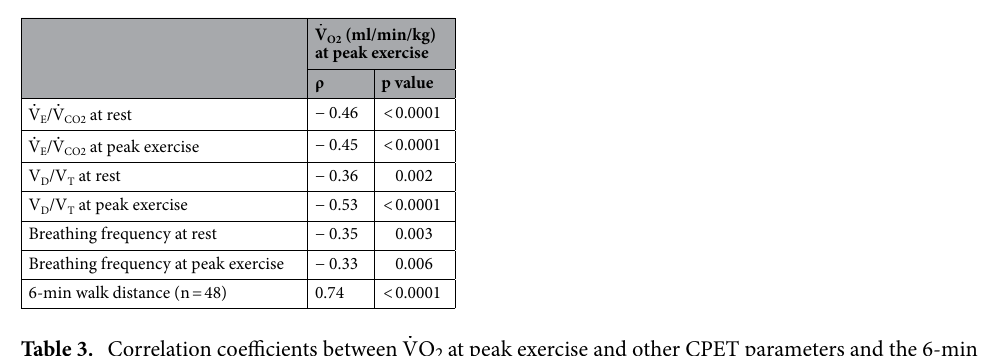
˙ V ˙ V E / CO2 ventilatory equivalent for